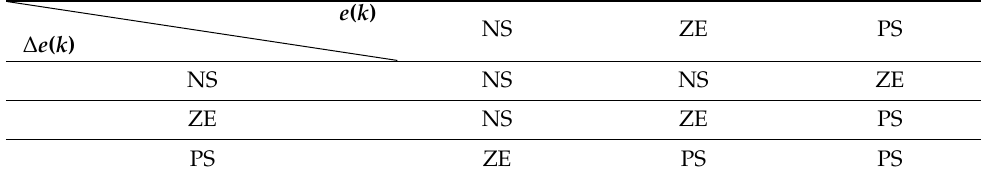
Figure 6. The defuzzifier membership function of the type-II controller. Table 4. Type-II fuzzy rule table for ( i = 1, 2, 3). ∆ e ( k